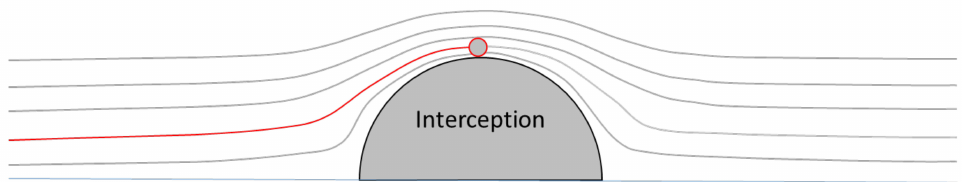
Figure A5. Interception deposition